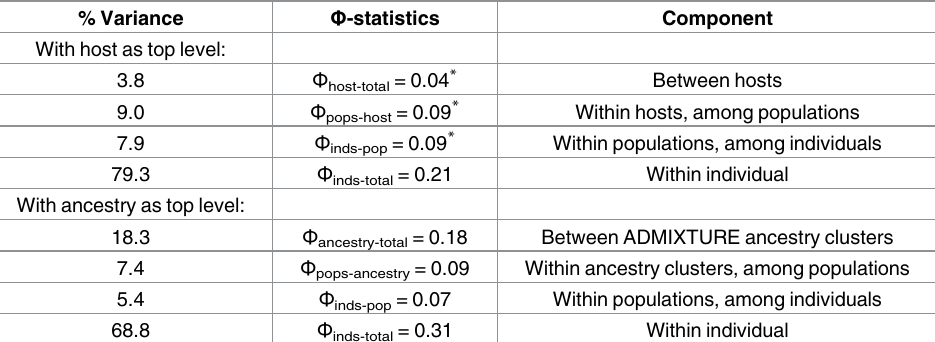
Table 2. Results of two Analysesof Molecular Variance (AMOVAs) for samples within Washington. Populationswere separated by samplinglocationand time. % Variance Φ